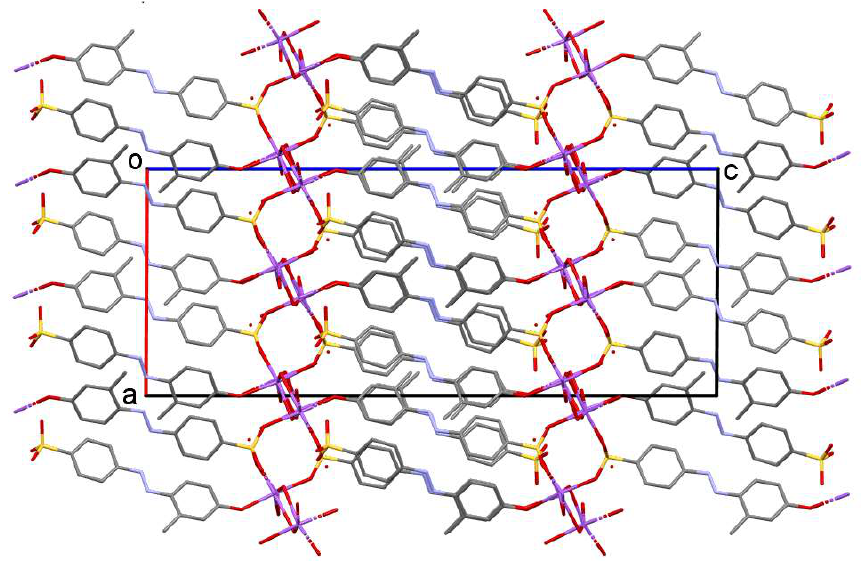
Figure 1. Packing diagram of structure Na4 as viewed down the crystallographic b axis. H atoms omitted for clarity. Note the alternating inorganic and organic layers parallel to the ab plane. Here and elsewhere, purple = Na or other group 1 metal, yellow = S, red = O, blue = N, grey = C.